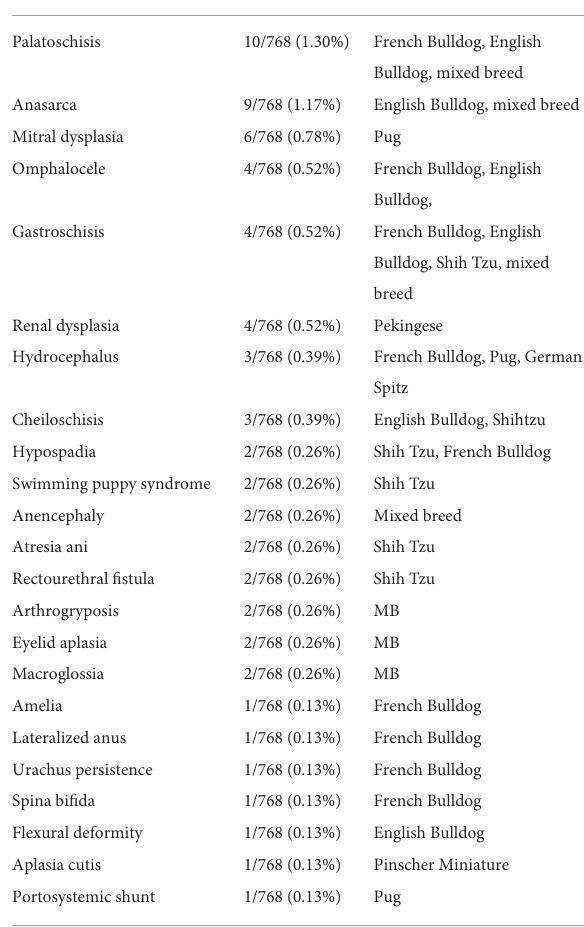
TABLE 1 Type of neonatal malformation and frequency by breed. Type of malformation